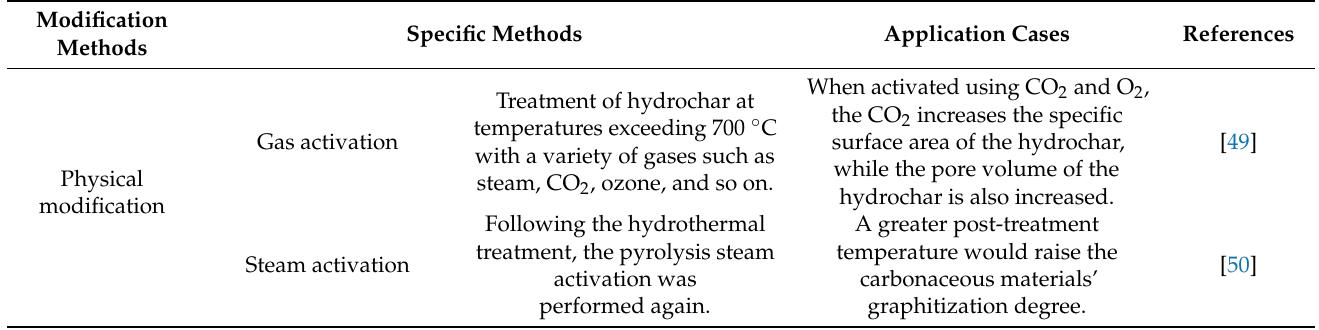
Table 2. Physical and chemical modification methods and application examples of hydrochar .